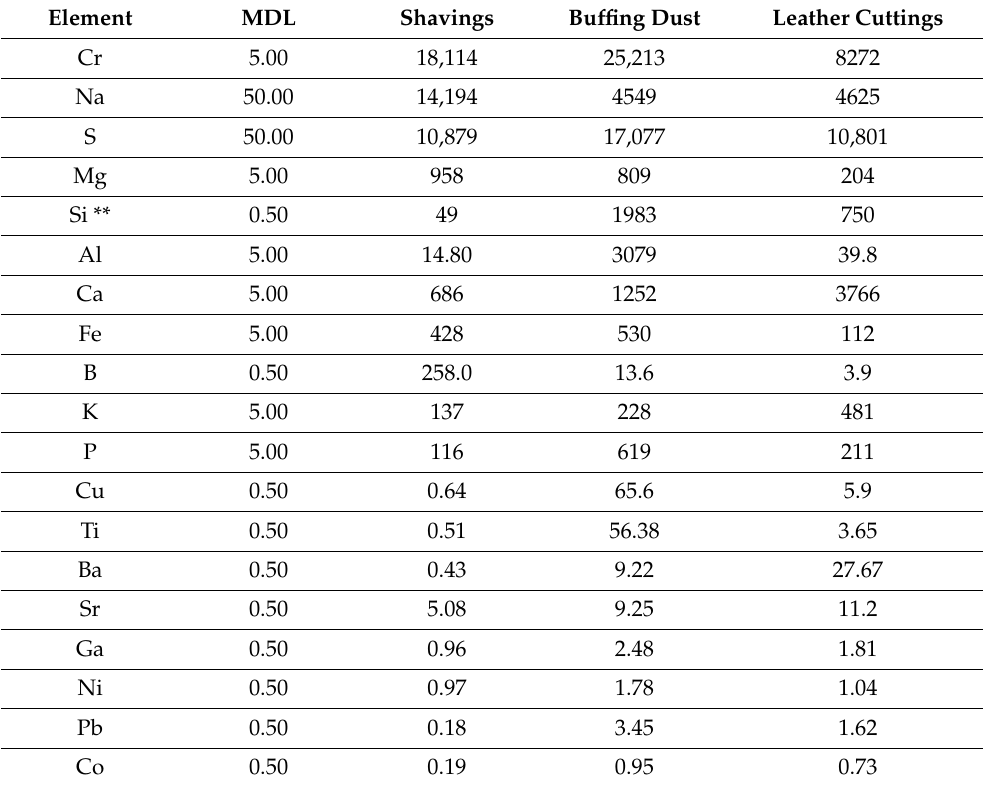
Table 2. The elemental concentration of the chromium-containing leather wastes. All units are in mg/kg. MDL stands for measurement detection limit [7]. ** There were insoluble Si in the samples. Element MDL Shavings Buffing Dust